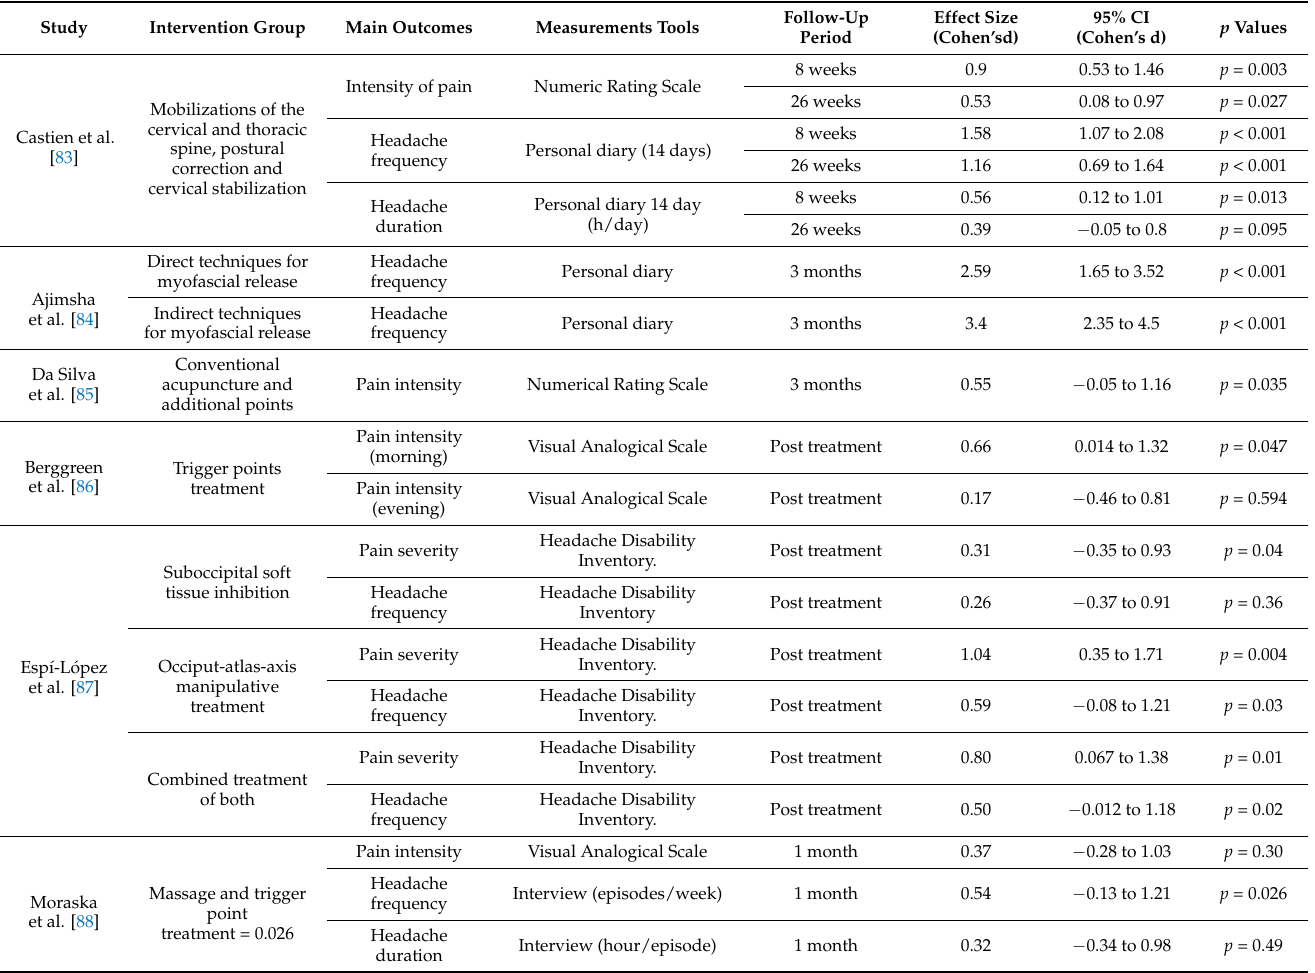
Table 3. Results of individual